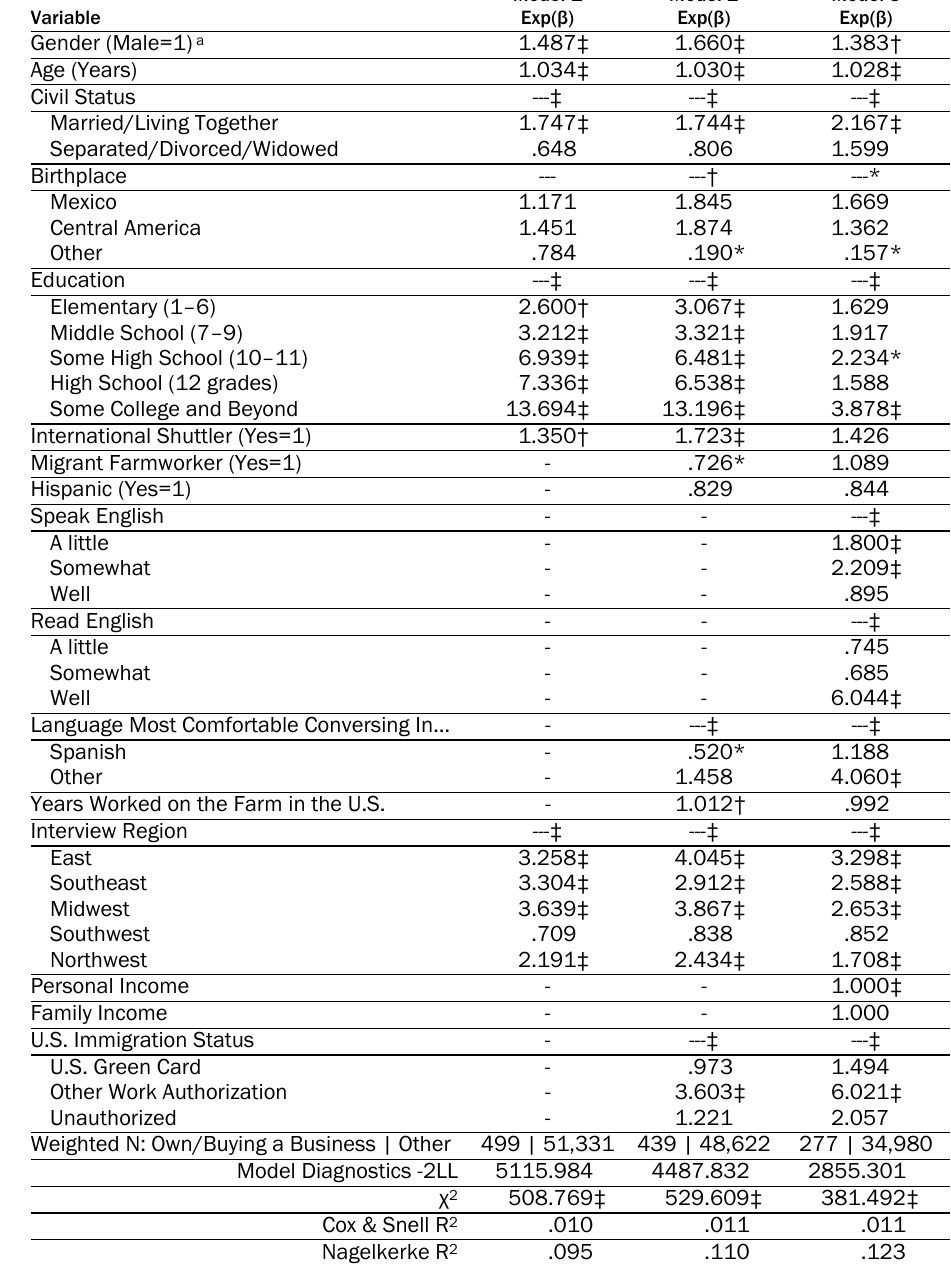
Table 2. Logistic Regression Results (Odds Ratios) for Farmworker Business Ownership (Business